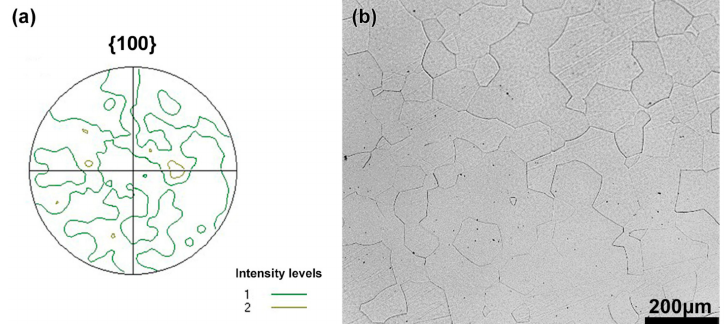
Figure 1a. The microstructure of Ti-5Al-5Mo-5V-1Cr-1Fe alloy after being held at 1223 K for 5 min is shown in Figure 1b. The initial grains of the alloy are equiaxed with a size in the range of 80–100 µ m.